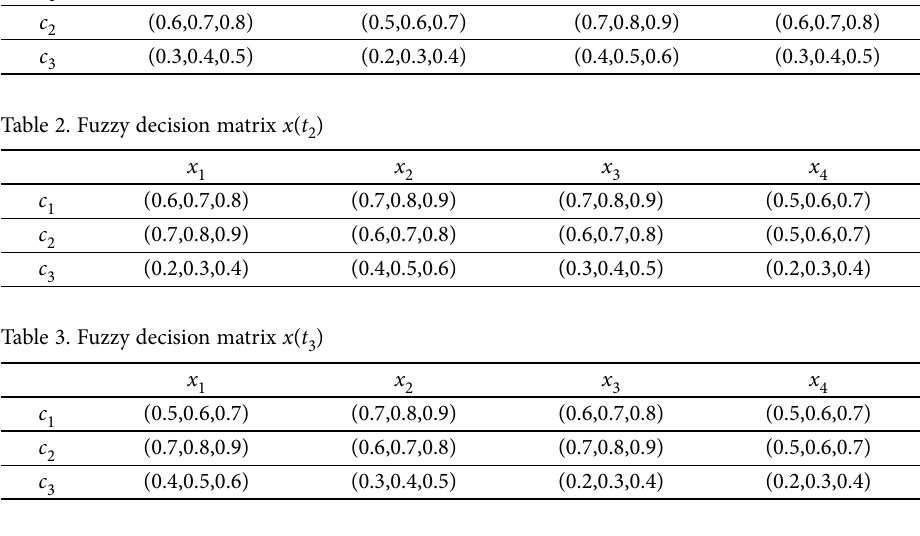
Table 4. Normalized fuzzy decision